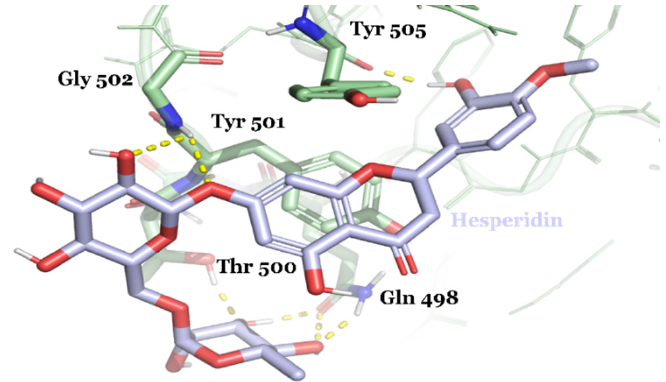
Figure 8. A representative snapshot of the docking pose of hesperidin with the Delta variant. B.1.617.2 (Delta’s) residues are colored according to the atom type of the interacting amino acid residues (protein’s carbon, pale green; oxygen, red; nitrogen, blue). Dash lines represent the protein– ligand interactions: hydrogen bond interactions are colored in yellow; π - π interactions are colored in blue; π -cation interactions are colored in green.